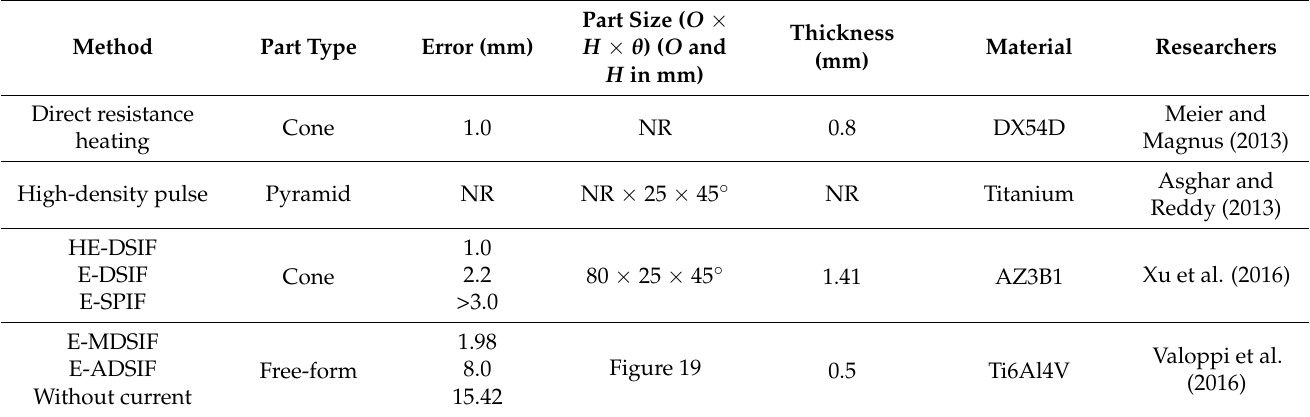
Table 3. Accuracy improvement based on the heat-assisted